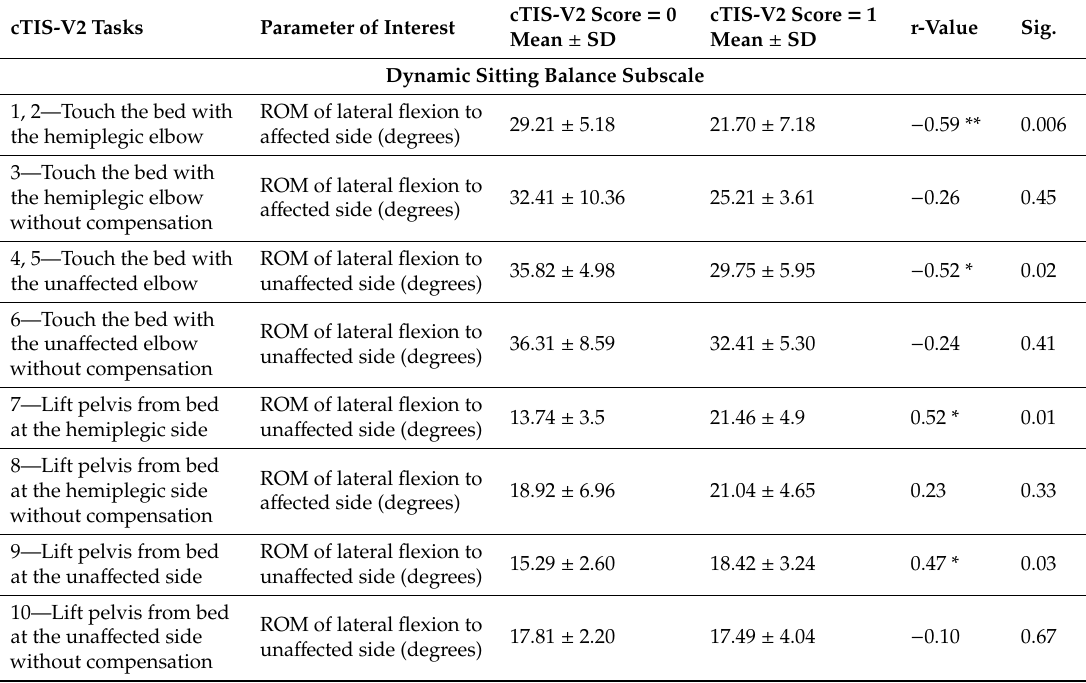
Table 3. Spearman rank correlation of iTIS data with cTIS-V2 score (dynamic subscale) in the stroke